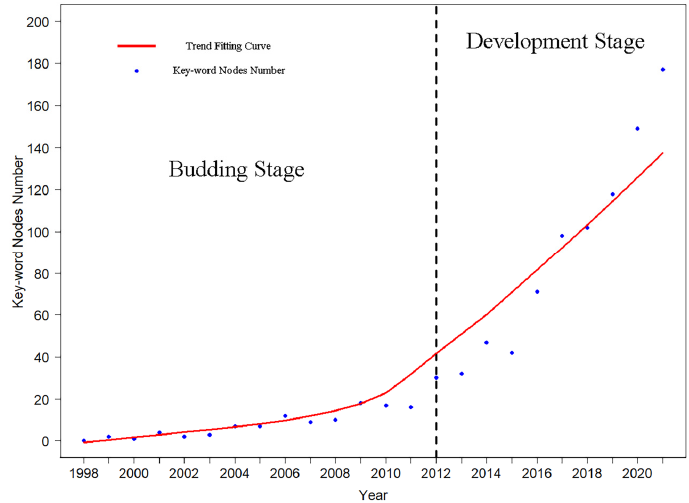
Figure 6. Annual change of keyword nodes number and research development progress.